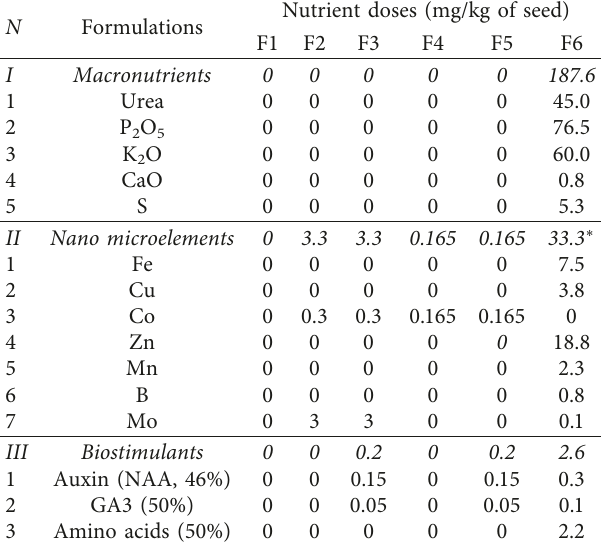
Table 2: Germination rate of soybean seeds treated with different formulations (experiment on agar medium),